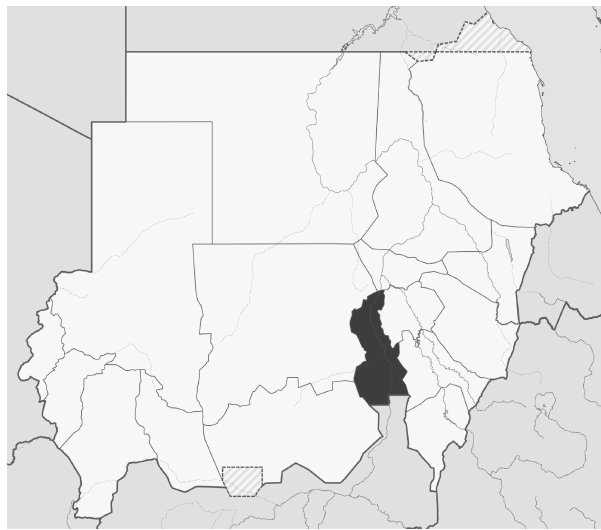
Figure 1: Study site: White Nile area in Sudan.